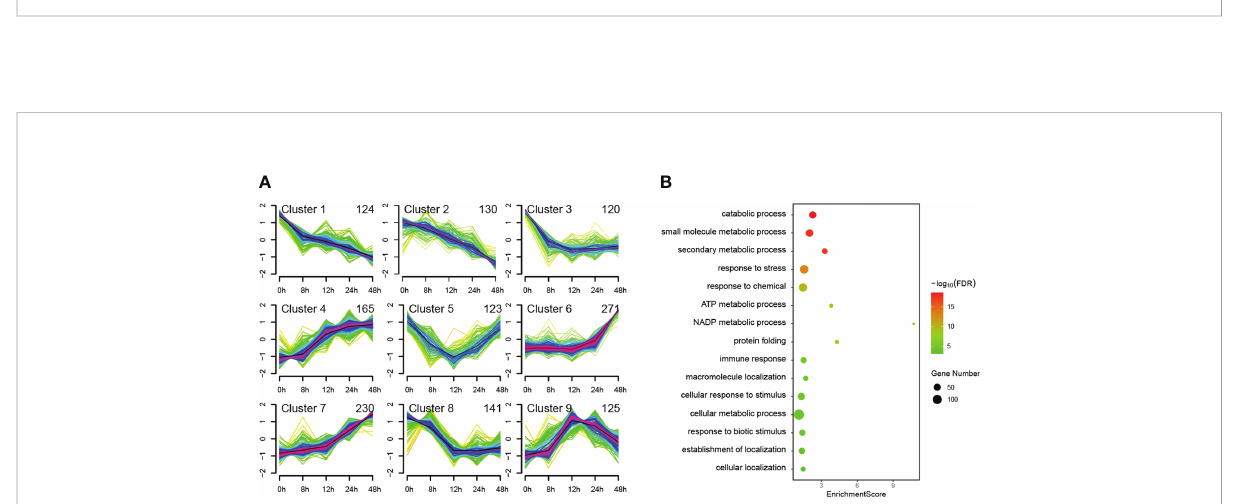
FIGURE 4 Cluster and GO enrichment analysis of 1429 differentially expressed proteins (DEPs). The identi fi ed 1429 DEPs were clustered in mainly nine types of temporal patterns according to their protein expression pro fi les (A) and GO enrichment analysis was performed on the DEPs of cluster 7, of which the top 15 GO terms for Biological Process belonging to level 3 are presented (B)